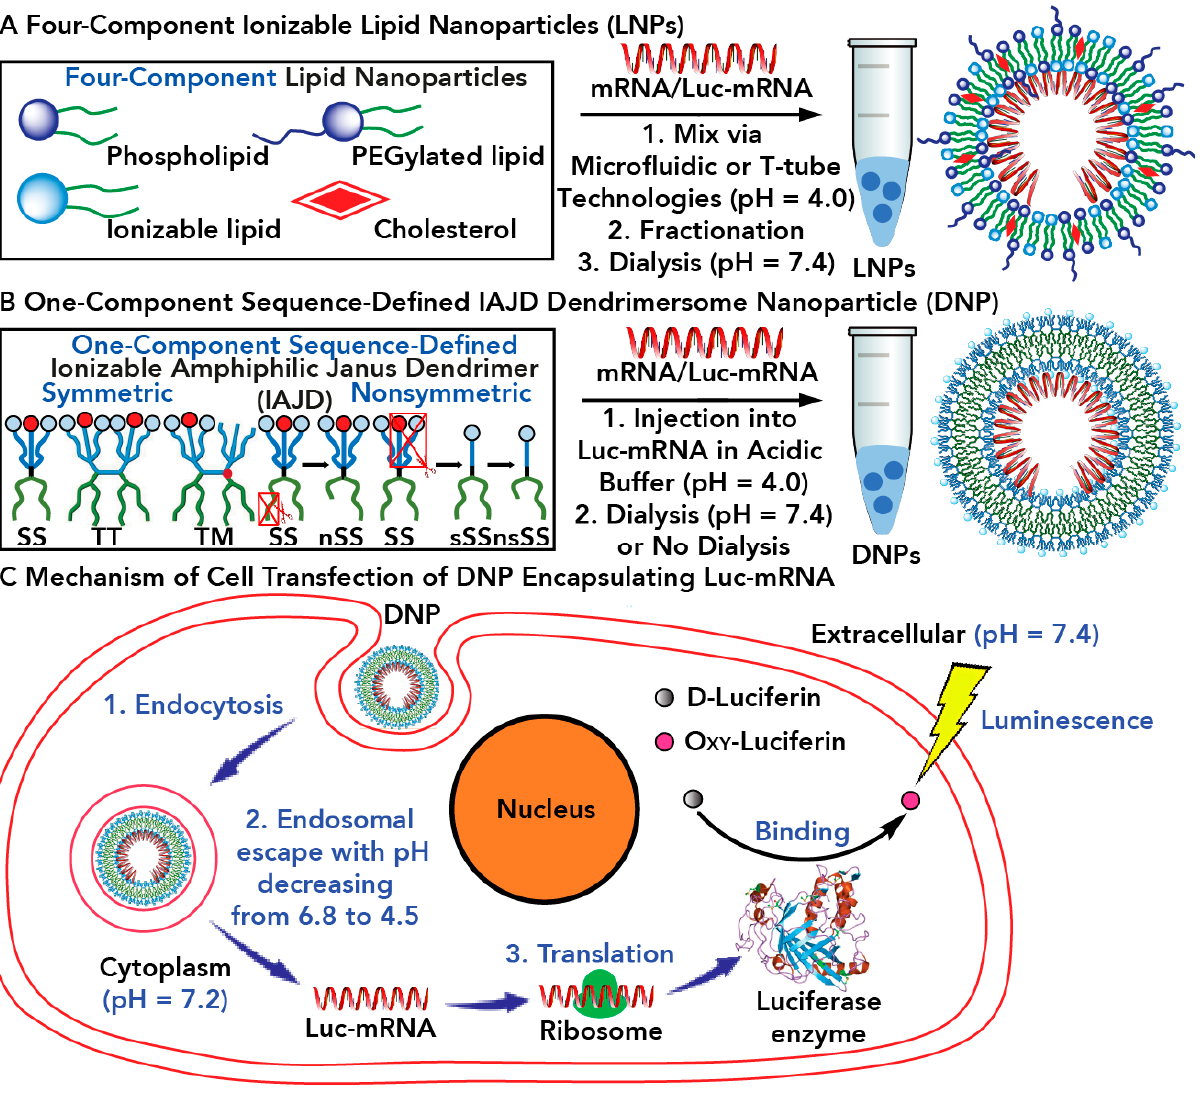
Figure 26. Schematic representation of four-component LNPs, one-component IAJDs based DNPs, and the cell transfection mechanism of LNPs and DNPs encapsulating Luc-mRNA ( A ) Four-component LNPs. ( B ) One-component IAJDs and their DNPs. ( C ) Cell transfection mechanism of LNPs and DNPs encapsulating Luc-mRNA.